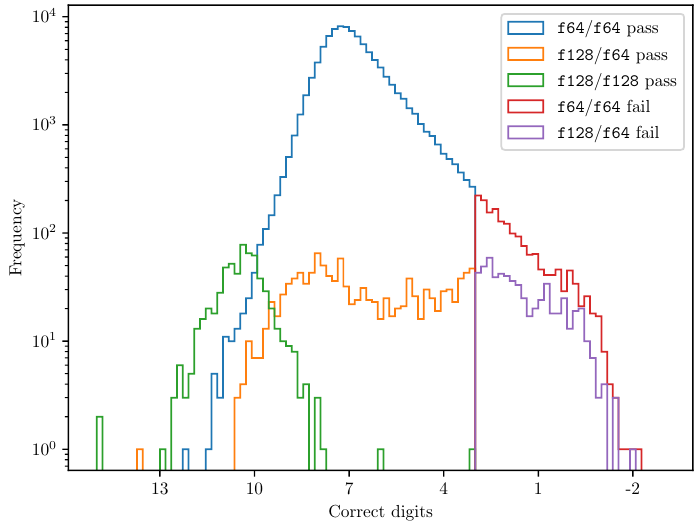
Figure 3 . Histogram of the error estimate on the two-loop evaluations as given by the scaling test. We use the evaluation strategy with a target accuracy of three digits and show errors for all precision levels. We see 1 . 8 % of points failing f64 / f64 evaluation, with 1 . 2 % passing at f128 / f64 and 0 . 6 % passing at f128 / f128 . The evaluation strategy achieves target accuracy for all of the 100 000 physical phase-space points